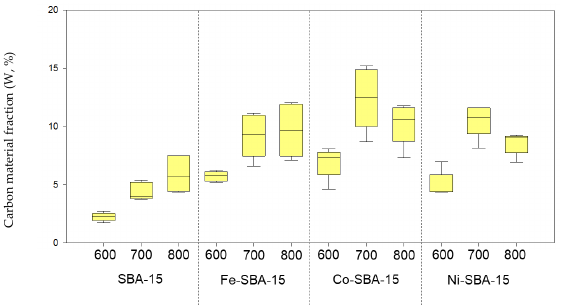
Figure 7. Carbon materials formation on SBA-15, and Fe-, Co-, and Ni oxides-impregnated SBA-15 at 600, 700, and 800 °C.